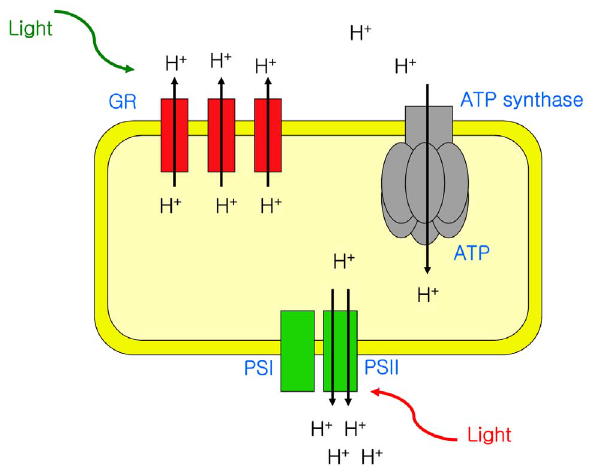
Figure 6. Schematic model of energy production in Gloeobacter . The photosynthetic apparatus of Gloeobacter is reproduced from